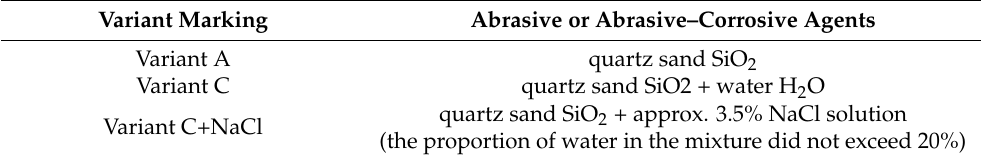
Table 3. Combinations of damaging